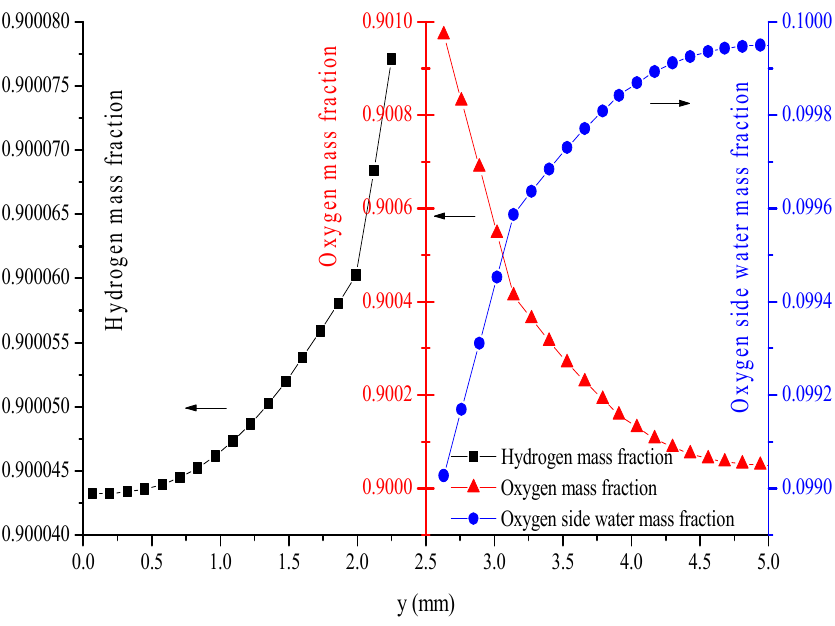
Figure 7. Parameter distributions along line A–A at 3 s. Figure 8a,b show the time-dependent evolution of the average mass fractions of O 2 and H 2 in different layers. In the first ´ 2 s, the average mass fractions of O 2 and H 2 decrease to the minimum in each layer at approximately 0.2 s and remain unchanged for the rest of time. The electrochemical reaction rate is rapid and only takes a short time to reach the steady state from the transient state in the FC mode. The average mass fractions of O 2 and H 2 exhibit a larger reduction in the CL than in the other two layers because O 2 and H 2 provided in the gas flow channel and supplied to the CL are consumed via the GDL at the oxygen and hydrogen sides, respectively. Differences in the minimum between each layer are evident in the FC mode. At 0 s to 3 s, the average mass fractions of O 2 and H 2 rapidly increase to the maximum from the minimum and maintain constant for the remaining